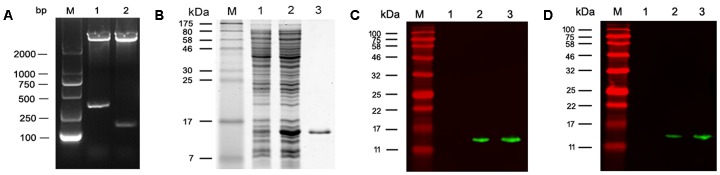
Expression and characterization of rMEP. (A) Restriction endonuclease digestion of recombinant plasmid pET28a-MEP. Recombinant plasmid pET28a-MEP was digested with Nco
I and Xho
I to release the insert. M: DL2000 DNA marker; lane 1: pET28a-MEP plasmid digested with Nco
I and Xho
I; lane 2: empty pET28a plasmid digested with Nco
I and Xho
I. (B) rMEP was highly expressed in E. coli BL21 lysates after IPTG induction analyzed by SDS - PAGE (10 μg, Lane 2), no expression of rMEP was shown in the uninduced E. coli BL21 lysate (10 μg, Lane 1); rMEP purified by Ni-affinity chromatography was loaded in Lane 3 (1 μg). (C,D) The expressed rMEP was detected by Western blot in induced lysate (1 μg, Lane 2) or purified rMEP (50 ng, Lane 3), but not detected in uninduced E. coli lysate (1 μg, Lane 1) by an anti-His tag monoclonal antibody (C) or by anti-B cell epitope YX1 of Ts-Pmy mAb 7E2 (D).